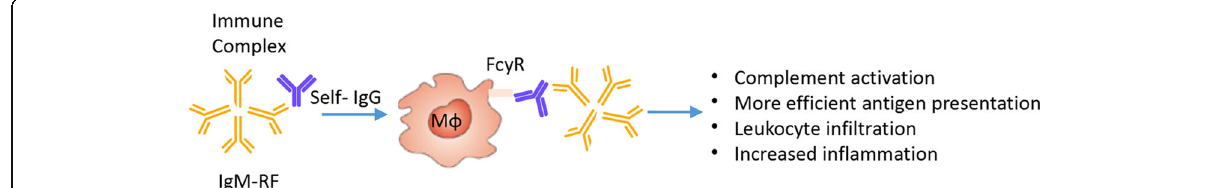
Fig. 1 The pathogenetic role of the rheumatoid factor: formation of immune complexes at the sites of synovial inflammation, activation of complement, and leukocyte infiltration, increasing